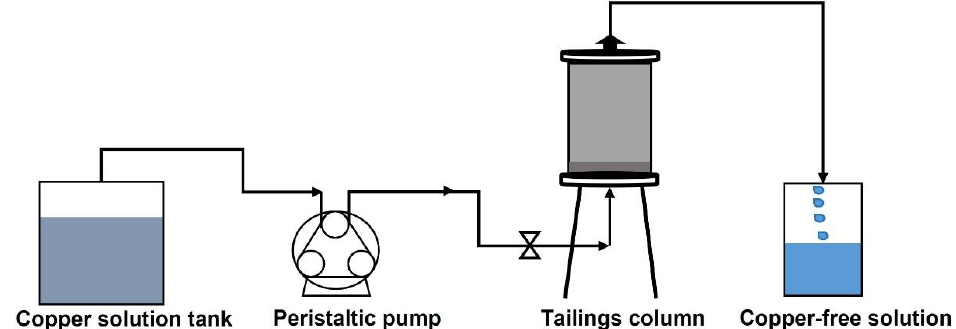
Figure 3. Column leaching sorption experimental setup.